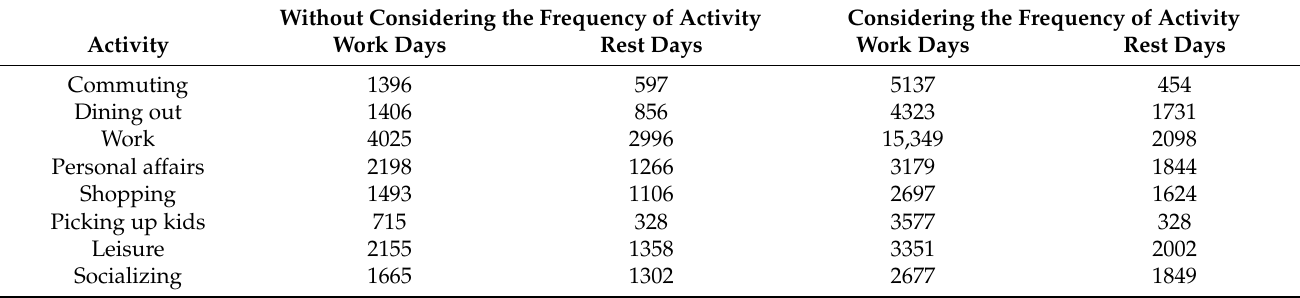
Table 2. Exposure risk level of each